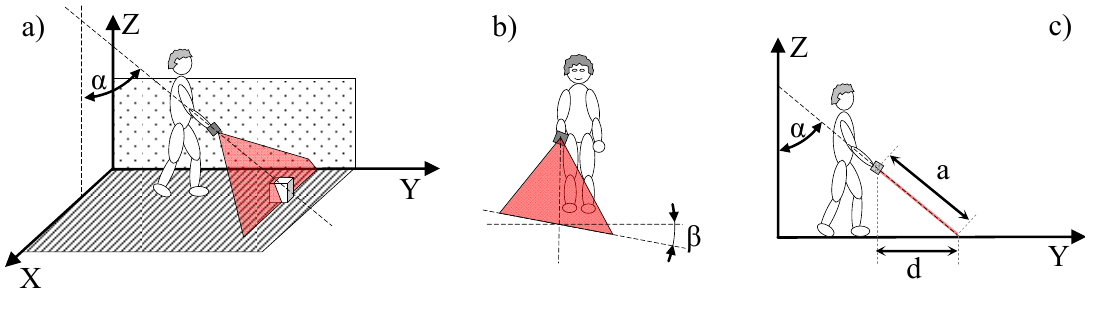
Figure 4 . Representation of the electronic white cane operating in floor mode: (a) vertical inclination angle α , (b) horizontal orientation angle β , and (c) distance, d, to the line defined by the intersection of the scan plane and the floor.